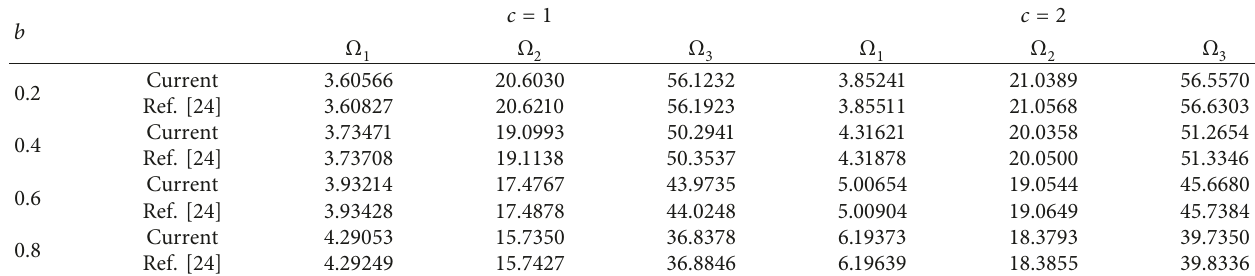
Table 3: Nondimensional natural frequencies for a tapered nonuniform beam with clamped-free (C-F) boundary condition and different cross-section parameters.